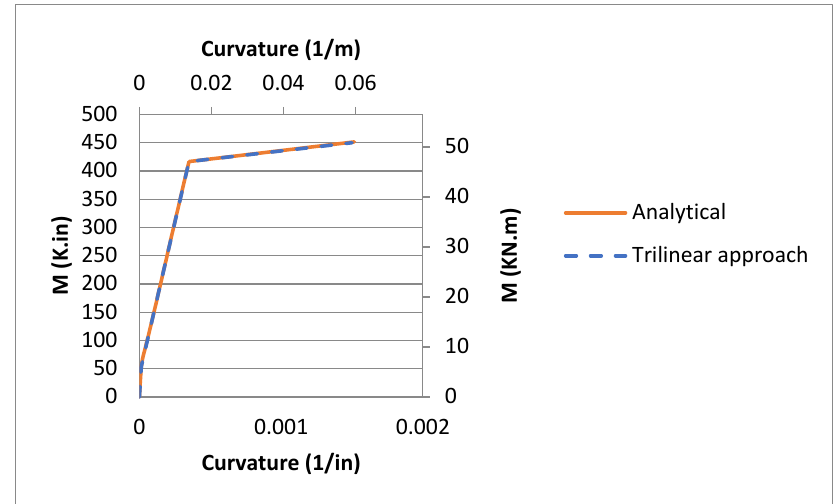
Figure 20. Decker (2007) [18] load vs. tensile steel strain comparison.